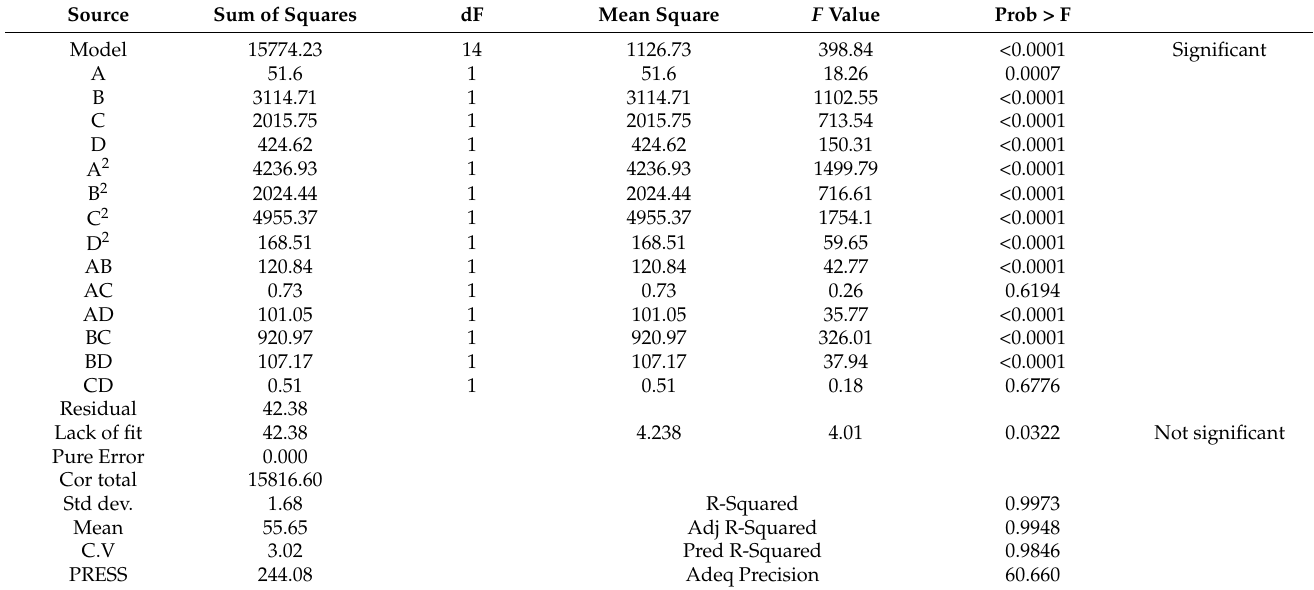
Table 11. Analysis of factors for central composite design on Reactive red 120 decolourisation by consortium